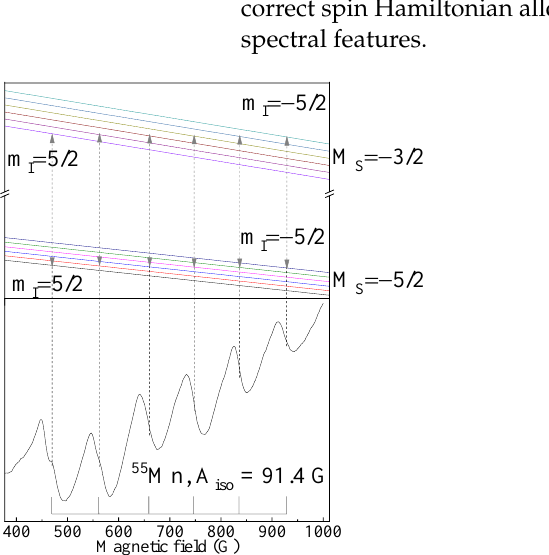
Figure 4. The scheme of hyperfine interaction levels and the nature of the formation of 6 lines due to the allowed spin transitions ∆ M S = − 3/2 − 5/2 and m I = 5/2 ( left panel ). A theoretical model of the angular dependence of fine structure components for Mn 2+ ions in a TCP sample ( right panel ).